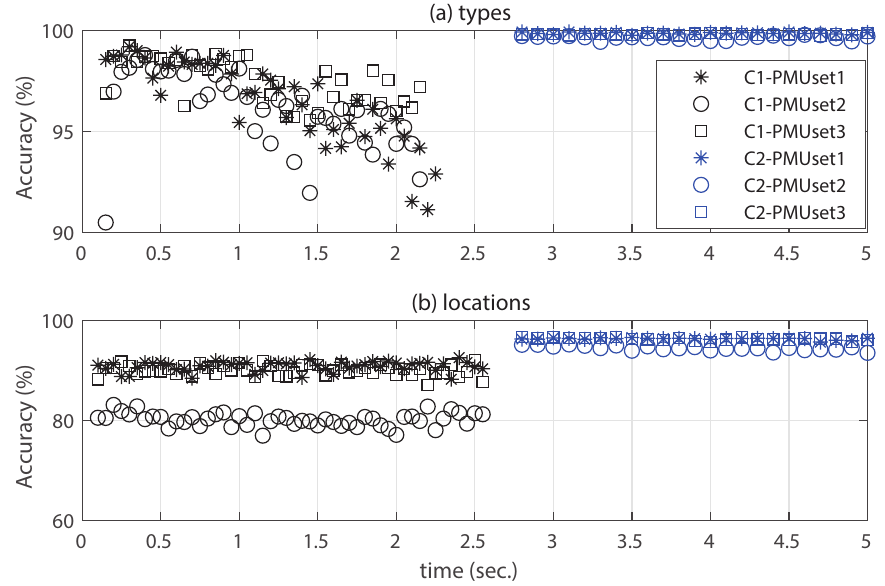
Figure 7. The single event identification performance: data acquisition time via